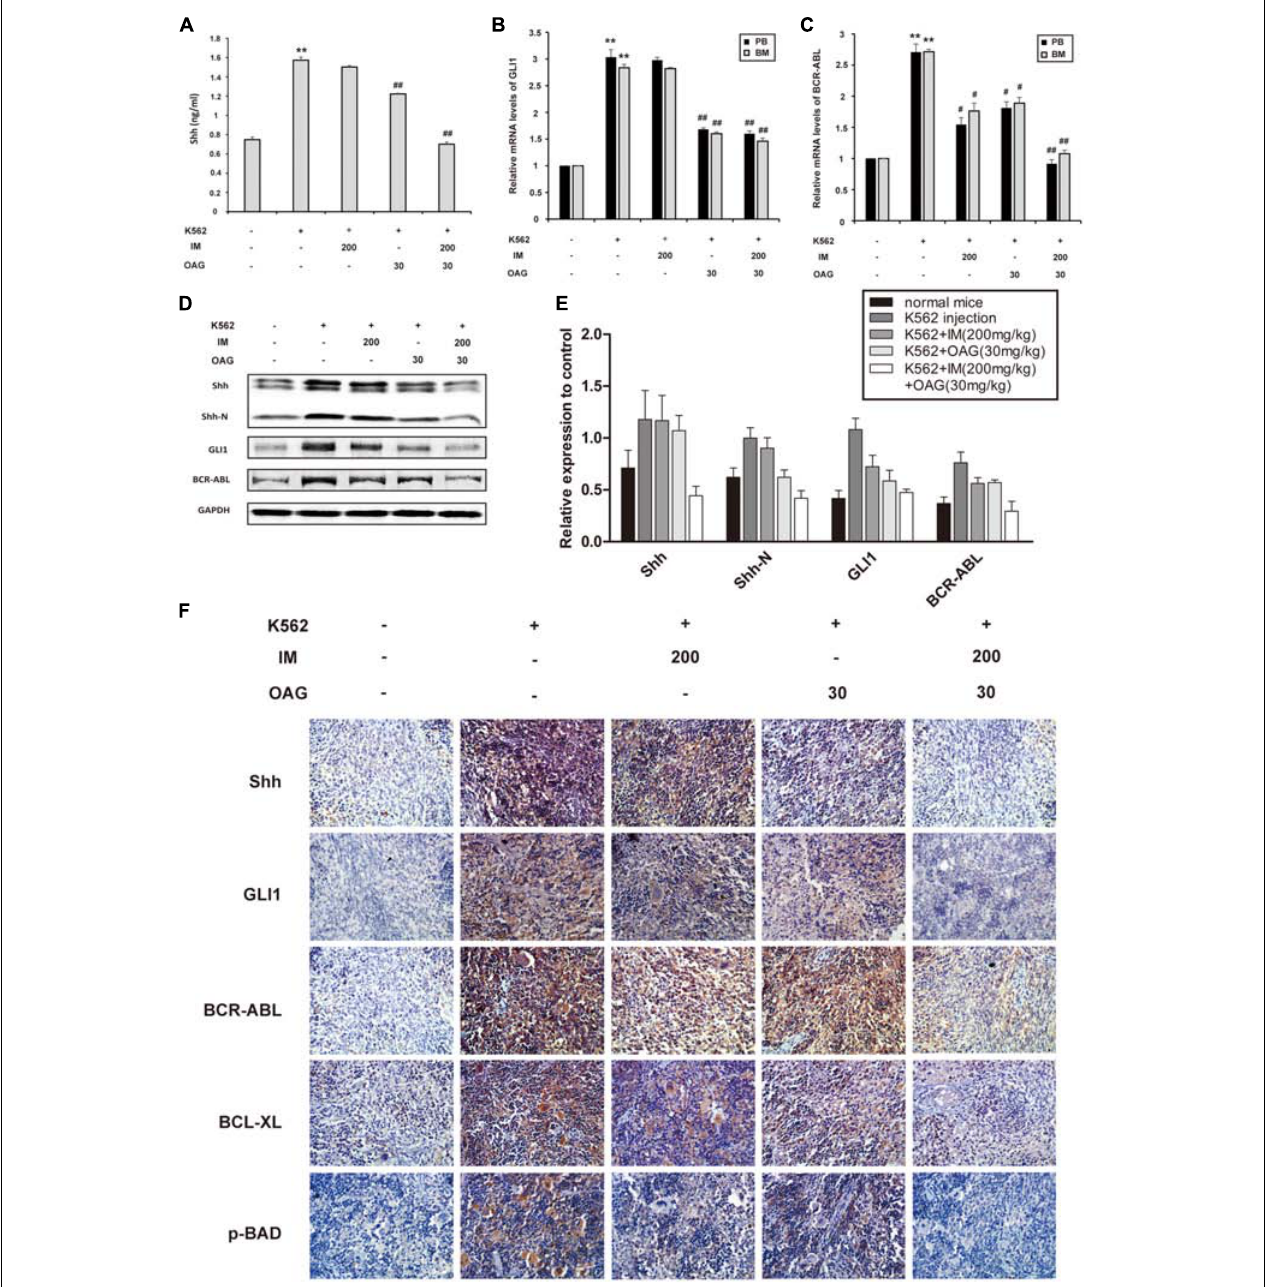
FIGURE 6 | Oroxyloside A suppressed hedgehog signaling and BCR-ABL expression combined with IM treatment in vivo . (A) The level of Shh cytokine in PB was evaluated by ELISA. (B) GLI1 and (C) BCR-ABL mRNA levels in PB and BM samples from tree mice of each group were detected by quantitative real-time RT-PCR and fold changes were normalized to GAPDH. The data represented mean values of three experiments ± SD. (D,E) Western blot and immunohistochemistry (F) was used to examine Shh, Shh-N, GLI1, BCR-ABL and other related proteins in spleen cells. ( ∗∗ p < 0.01 compared with blank group and # p < 0.05, ## p < 0.01 compared with control